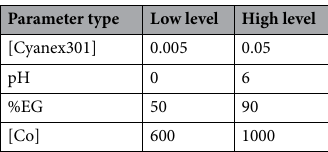
Table 1. Parameters and selected upper and lower levels with central composite design.